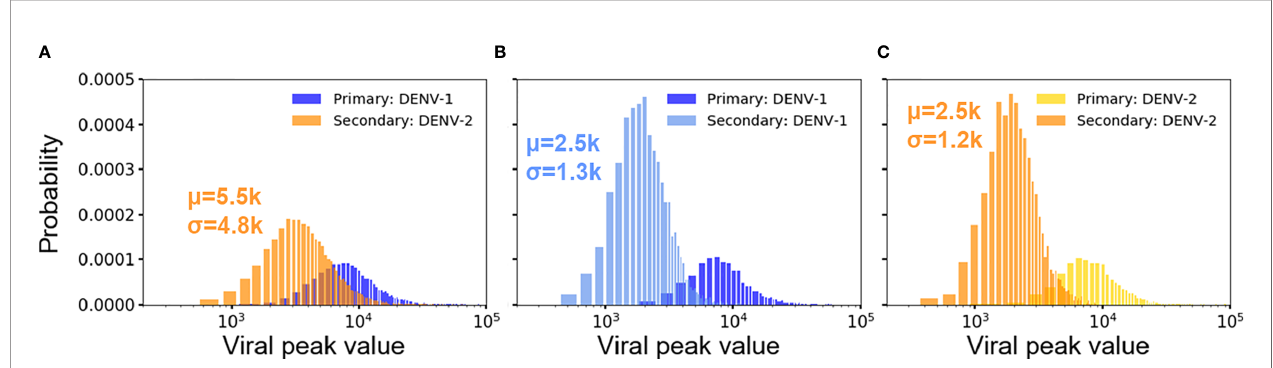
FIGURE 4 | Distribution of viral peaks from primary and secondary infections in heterotypic (A) and homotypic infections (B, C) from 10,000 independent simulations. Each viral peak value of concentration (n units x 10 3 /ml) comes from one simulation. Each plot includes the average concentration of viral peak ( m ) and standard deviation ( s ) for